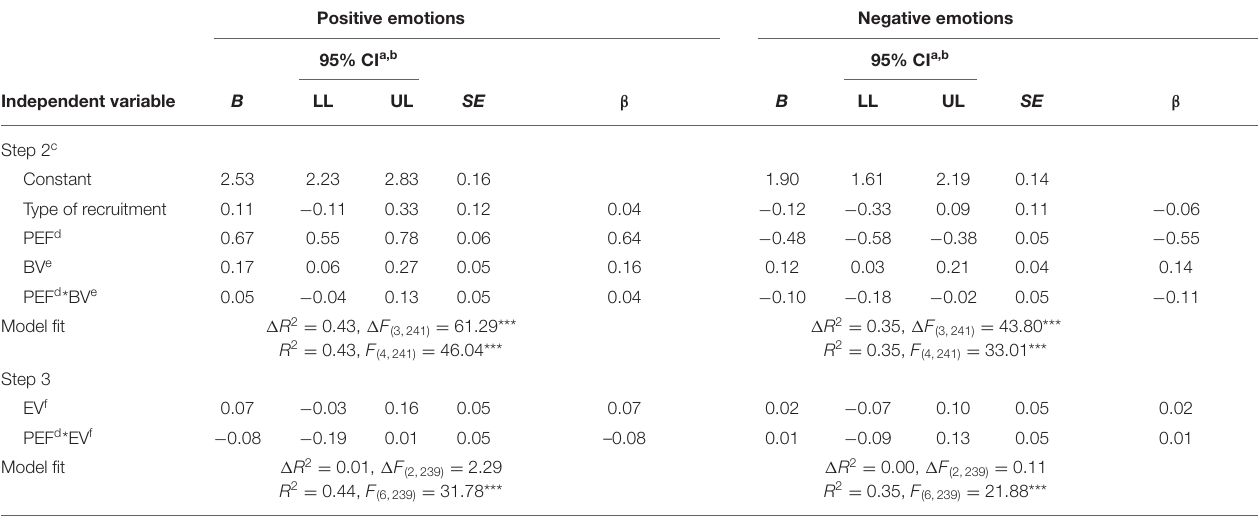
TABLE 7 | Regression coefficients of perceived environmental friendliness of algae-based biofuel, values, and their interactions on positive and negative emotions toward algae-based biofuel. Positive emotions Negative emotions 95% CI